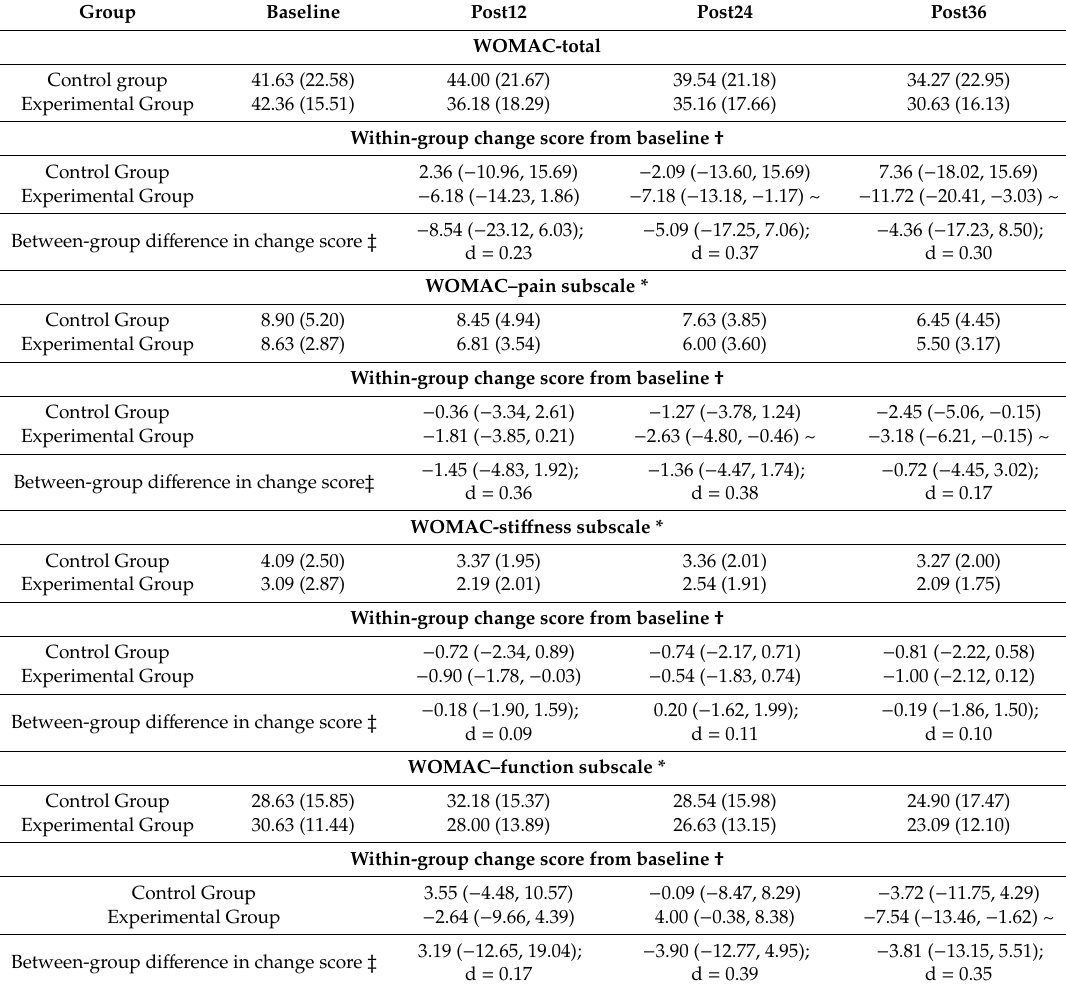
Table 4. WOMAC questionnaire